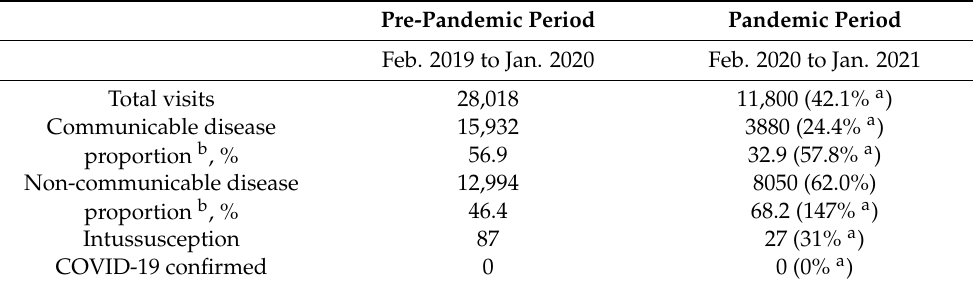
Table 1. Annual emergency department (ED) visits before and after the COVID-19 outbreak.